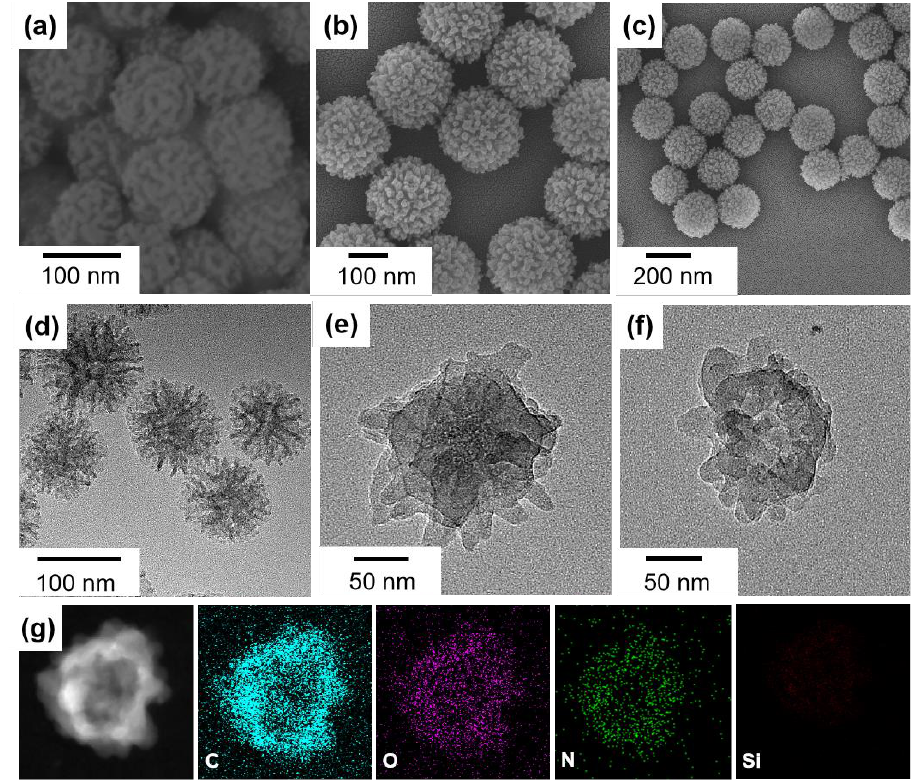
Figure 2. The SEM ( a – c ) and TEM ( d – f ) images of the DMSN ( a , d ), DMSN@COF ( b , e ), and COF HP ( c , f ). The EDX elemental mapping of COF HP ( g ).